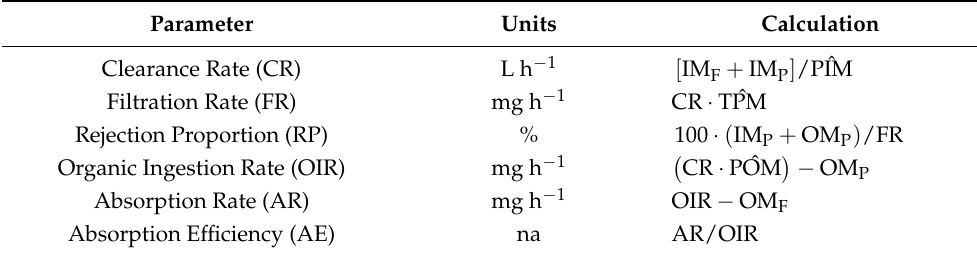
Table 1. Equations used to derive feeding behavior parameters of Mytilus galloprovincialis when subjected to water collected from the Swan-Canning Estuary. IM and OM (inorganic and organic matter, respectively; mg h − 1 ) in F and P (feces and pseudofeces), PIM, POM, and TPM (particulate inorganic, particulate organic, and total particulate matter in estuary water, mg L − 1 ). Parameter Units Calculation Clearance Rate (CR) L h − 1 [ IM F + IM P ] / ˆPIM Filtration Rate (FR) mg h − 1 Rejection Proportion (RP) Organic Ingestion Rate (OIR) mg h − 1 Absorption Efficiency